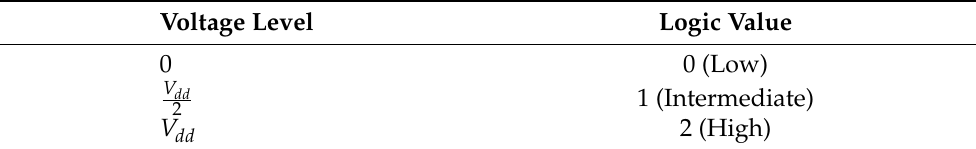
Table 1. Logic symbols.